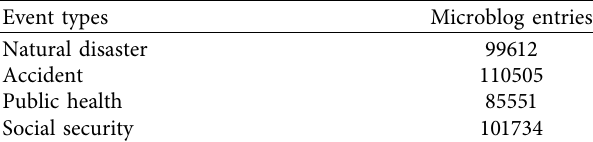
Table 1: The number of posts of each